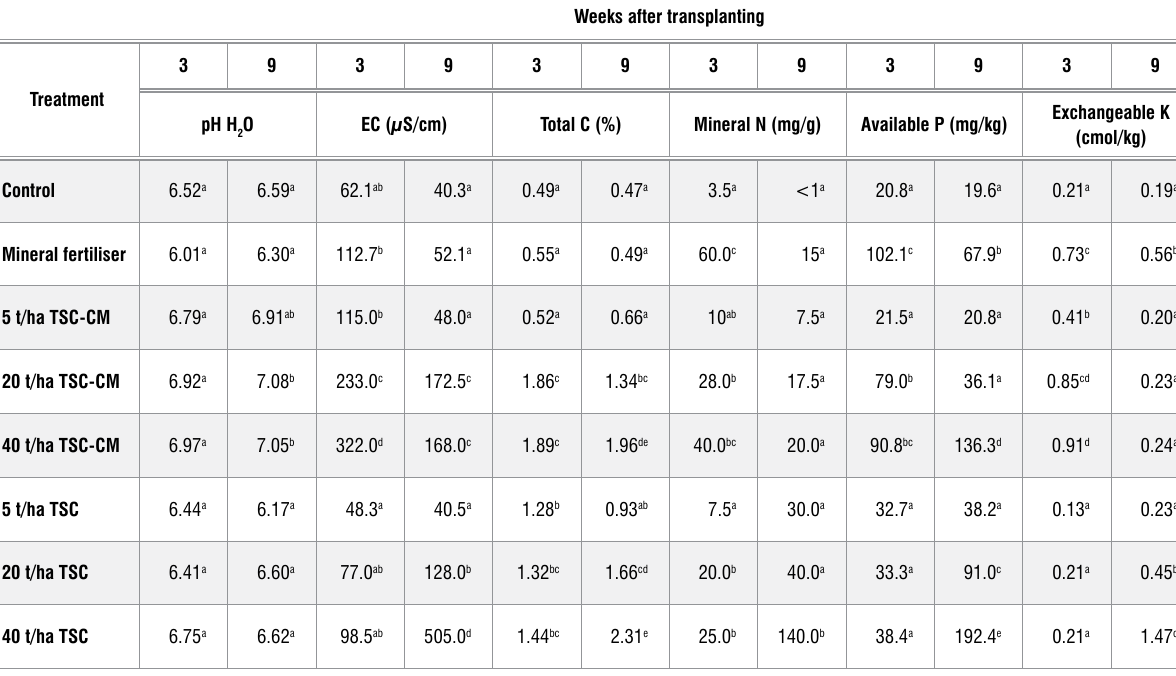
Weeks after transplanting